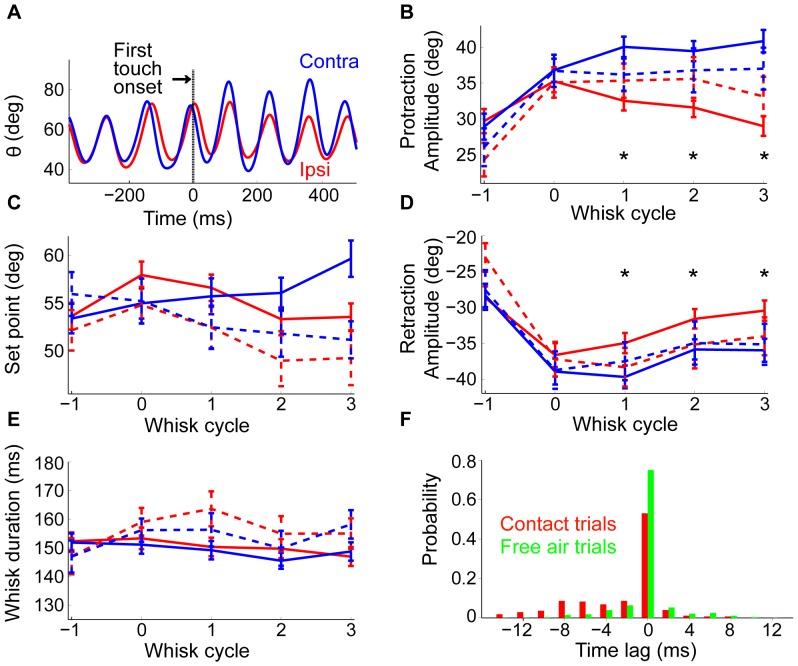
Whisking amplitudes, durations, and set-points after first touch.
A. Whisking angle of the ipsilateral C1 whisker (red) and contralateral C1 whisker (blue). Onset of the first touch in a trial is marked by a vertical line. B. Protraction amplitudes of whisker C1 as a function of whisk cycle, around first touch (red, blue) or first pseudo touch (dotted red, dotted blue). Ipsilateral C1 whisker (red, dotted red) and contralateral C1 whisker (blue, dotted blue). The most rostral untrimmed whisker C2 is touching the pole (the rare trials where whisker C1 also touched the pole in any of the first contacts were excluded from this analysis). Whisk cycle 0 is the first whisk with touch (or pseudo touch) in the trial. Asterisks indicate significant difference between ipsi and contralateral sides. We note that since the number of pseudo-touches was smaller than the number of real contacts, the error bars in the pseudo-touch trials were usually larger. C. Set point around touch as a function of whisk cycle. D. Same as B, but for retraction amplitude (negative value indicates retraction). E. Whisk duration around first touch. F. Probability of time-lags for contact and free-air trials.